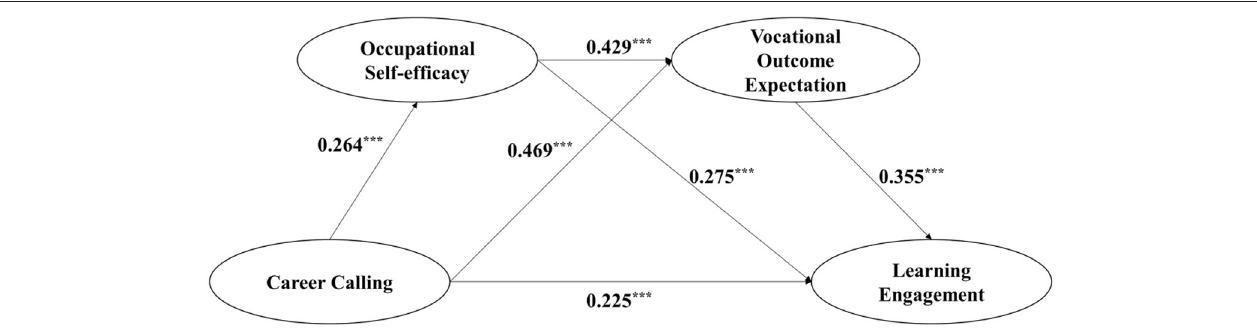
FIGURE 2 | The serial mediation model with occupational self-efficacy and vocational outcome expectation as mediators of the linkage between career calling and learning engagement. ***p < 0.001.